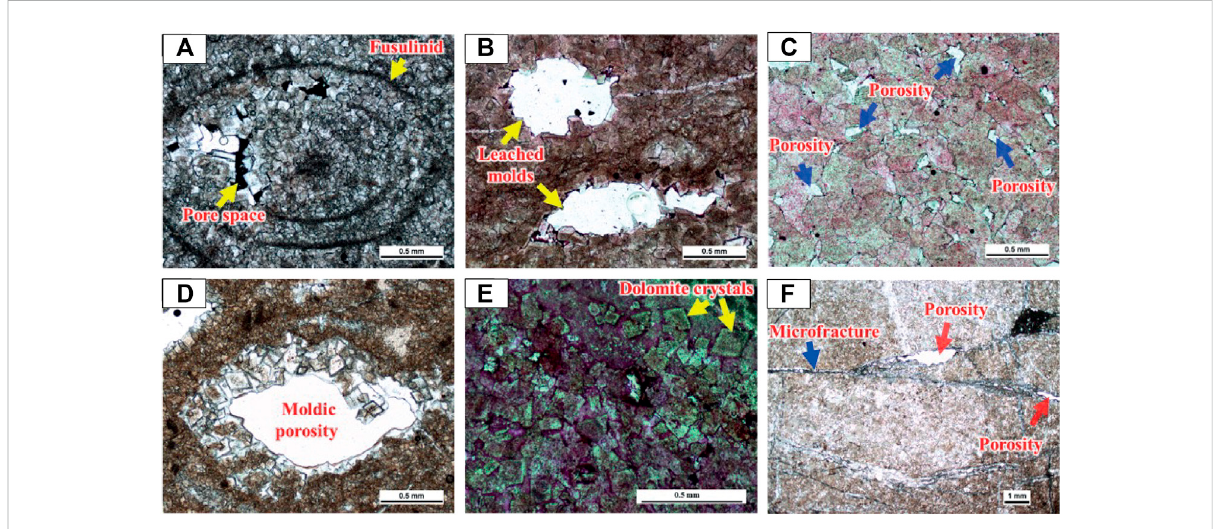
FIGURE 8 Photomicrographs of the dolomitized limestone from the Permian carbonate outcrops (modi fi ed from Kananusak, 2020). (A) a partially dolomitized fusulinid fossil with porosity, (B) dissolution pores with partially fi lled by dolomite, (C) intercrystalline pores (blue arrows) at crystal junctions, (D) crystal growths in moldic pore with partially fi lled by dolomite, (E) planar dolomite porphyrites in dolomized limestone, and (F) pores related to fractures (red